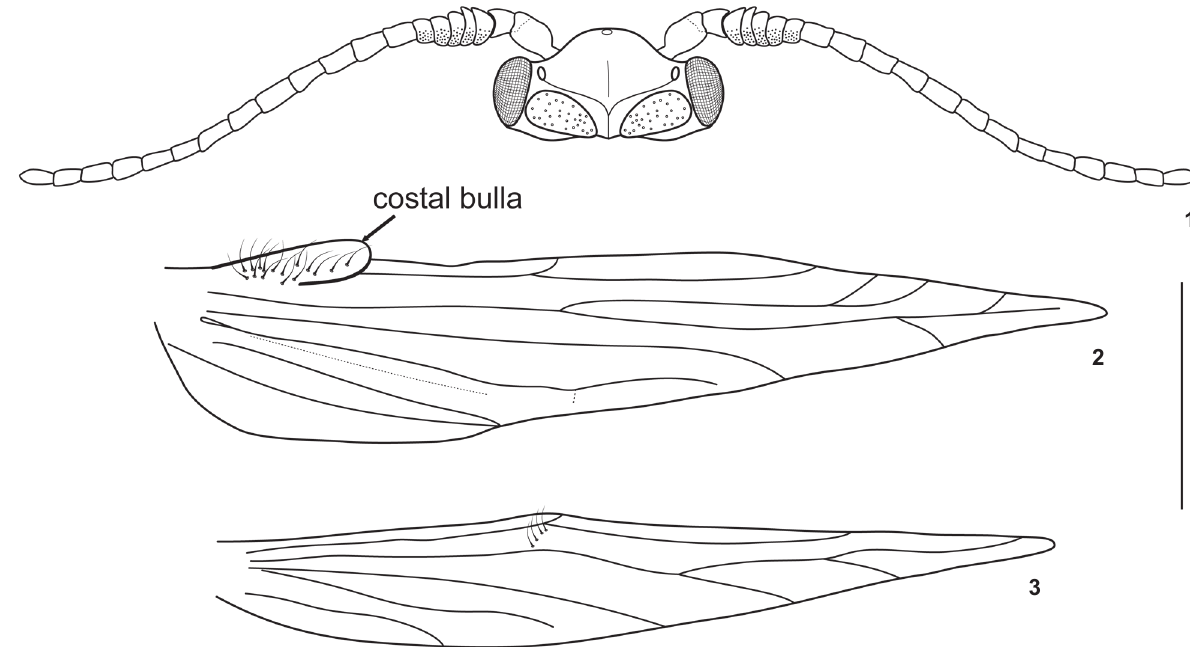
Figures 1-3. Costatrichia nelsonferreirai sp. nov. , male: (1) head, dorsal view; (2) forewing; (3) hind wing. Scale bar = 0.5